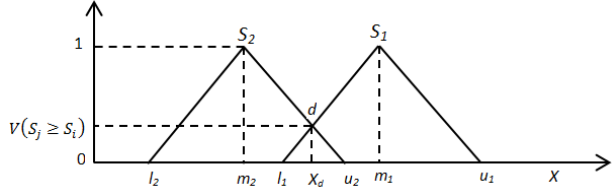
Figure 6. The comparison between two Fuzzy numbers.